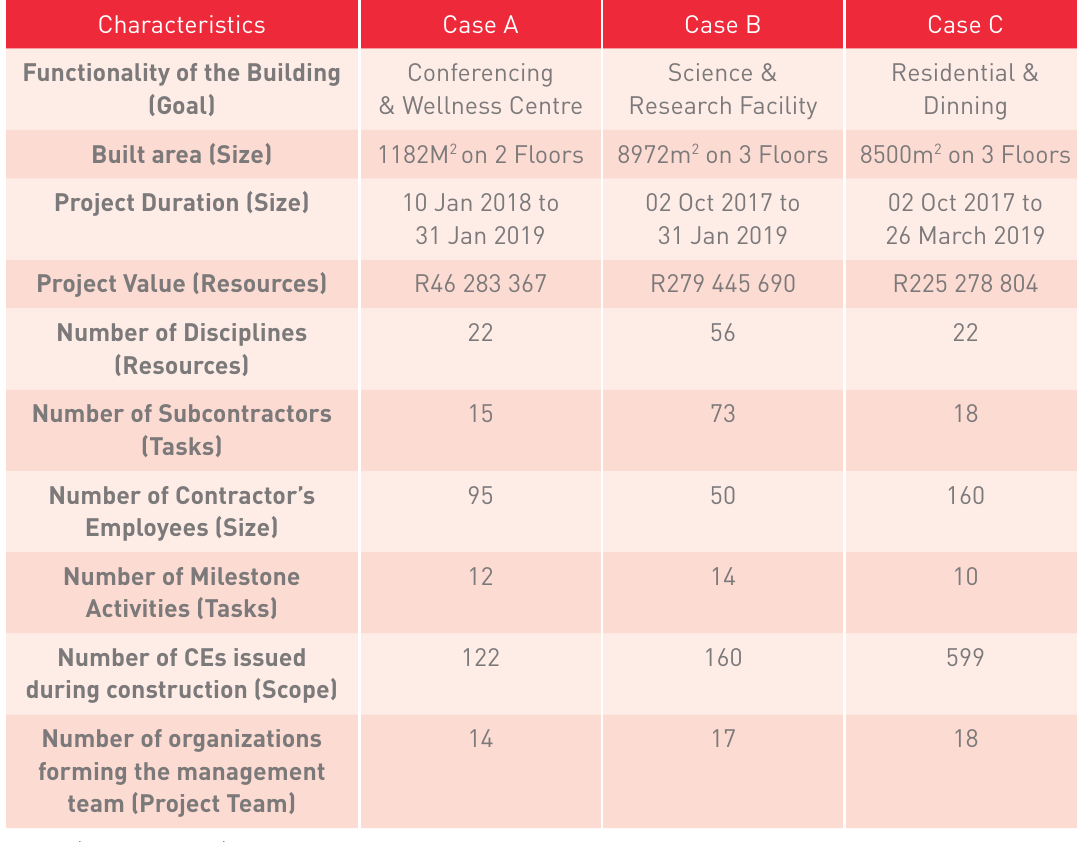
Characteristics of project complexities in the case study Characteristics Case A Case